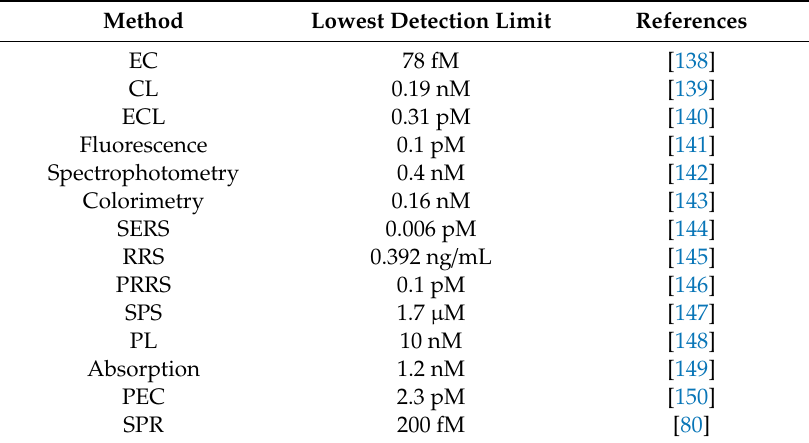
Table 2. Comparison of the detection limits of various DA